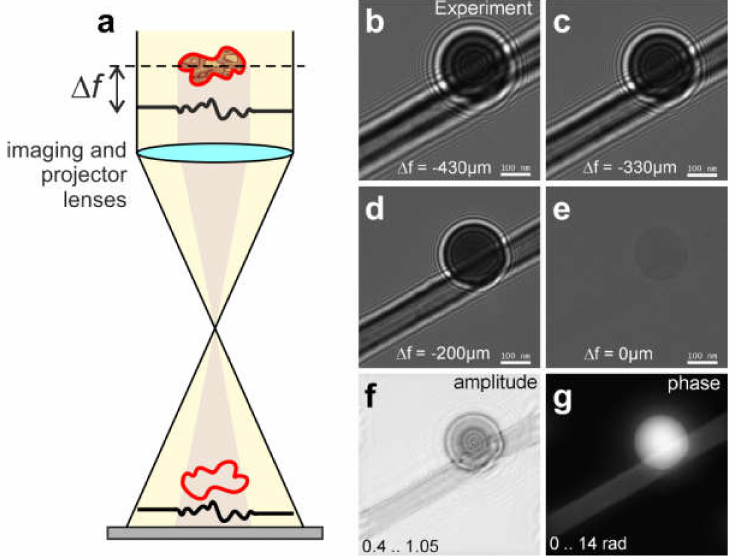
Figure 16. Defocus series in transmission electron microscope (TEM). ( a ) Drawing of a holographic in-line scheme, where the red (yellow) color represents the object (reference) wave and ∆ f is the defocus distance. ( b – e ) Experimental in-line holograms of a latex sphere recorded at di ff erent values of defocus. ( f ) Amplitude and ( g ) phase of the object wave, reconstructed using an iterative flux-preserving focal series reconstruction algorithm [71]. Reprinted from [53], with permission from